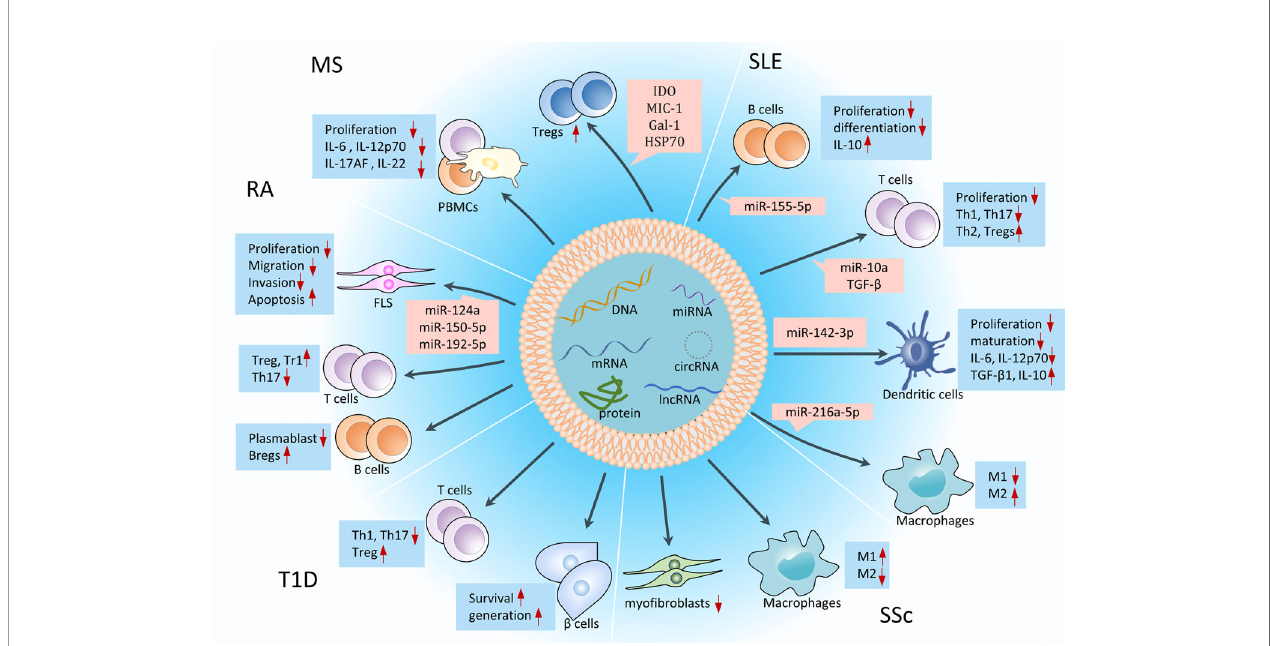
FIGURE 11 | Immunomodulation and tissue repair effects of MSC-Exos in AIDs. MSC-Exos can differentiate immune cells in the direction of suppressing in fl ammation, reduce the secretion of in fl ammatory cytokines, and repair damaged tissue cells in the body, such as FLS and b cells. miRNAs are the most studied substances on the mechanisms associated with MSC-Exos in the treatment of AIDs. Tr1, T regulatory type 1 cells; Th 17, T helper 17 effector cells; miR, microRNA; IDO, indoleamine 2,3-dioxygenase; MIC-1, macrophage inhibitory cytokine 1; Gal, galectin-1; HSP70, heat shock protein